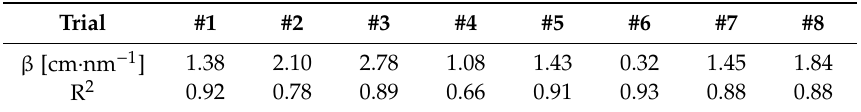
Table 1. Calibration coe ffi cient β used to reconstruct ∆ d ∆ λ B from ∆ λ B and R 2 coe ffi cients resulting from the linear regression between ∆ d L3 − L1 and ∆ λ B.